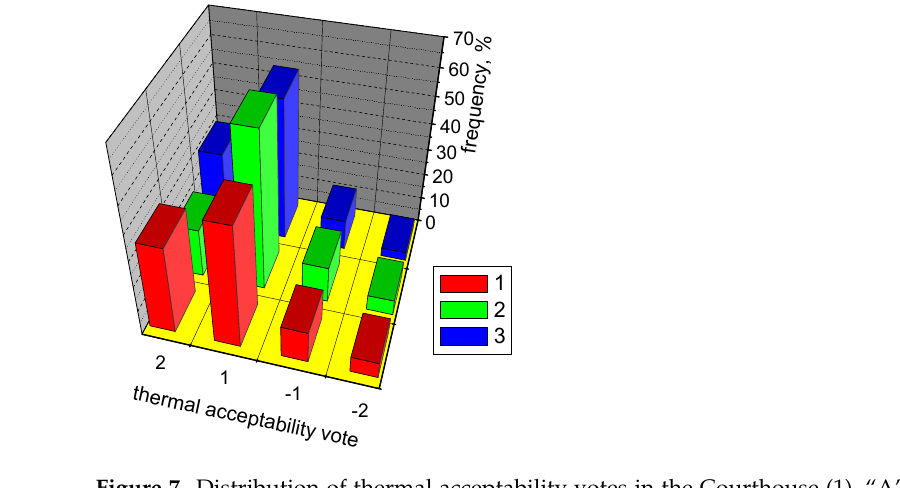
Figure 7. Distribution of thermal acceptability votes in the Courthouse (1), “A” building (2) and “Energies” (3).